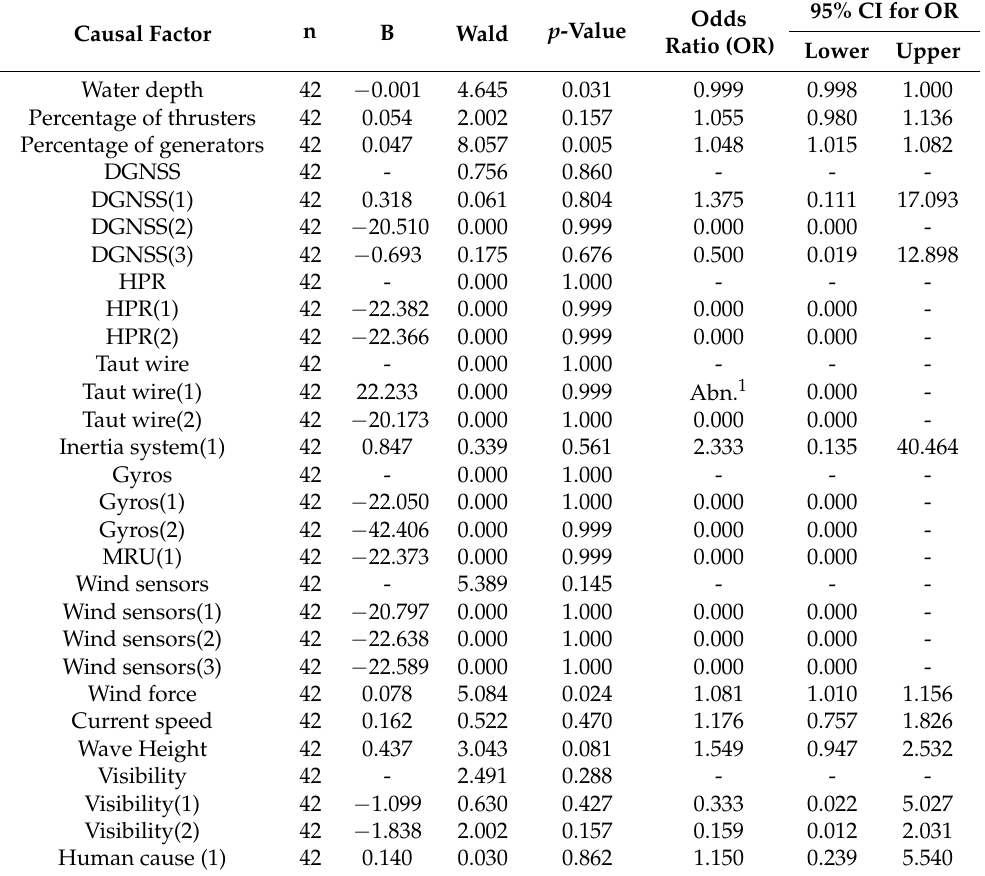
Table 2. Individual results for each independent variable when the binary regression model (method: Enter) is performed, with Excursion being the dependent